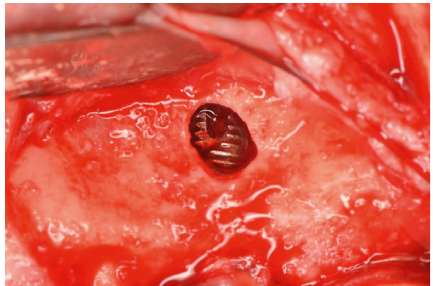
Figure 17: Exposed 7 threads of the